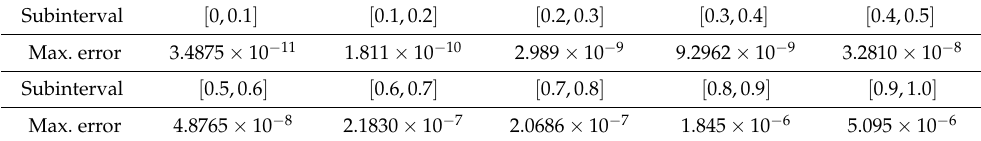
Table 8. Approximation errors for problem